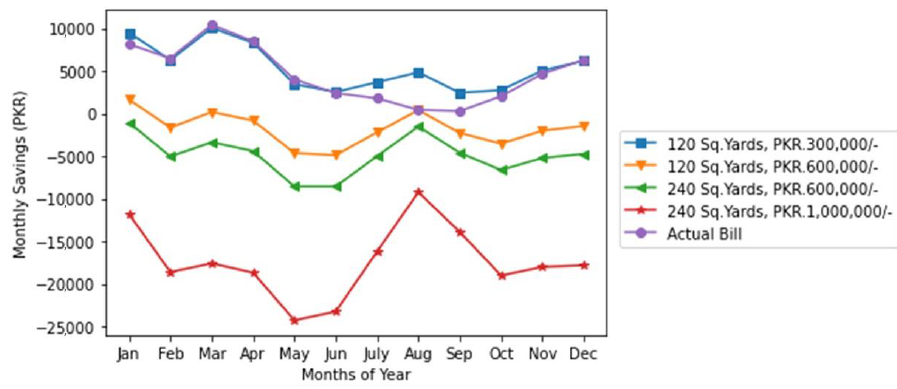
Figure 10. Monthly financial savings due to solar power.